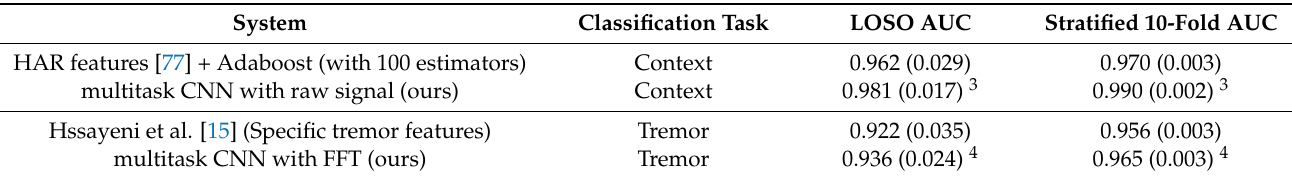
Table 6. Comparison of the performance of the best systems reproduced from previous works and the best CNN multitask systems. System Classification